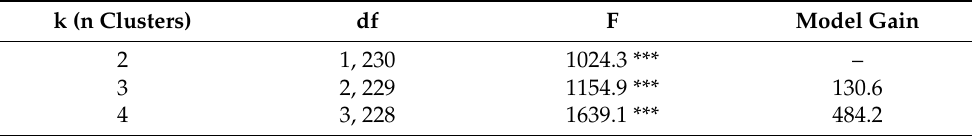
Table 8. ANOVA parameters for each iteration of the k-means cluster analysis.